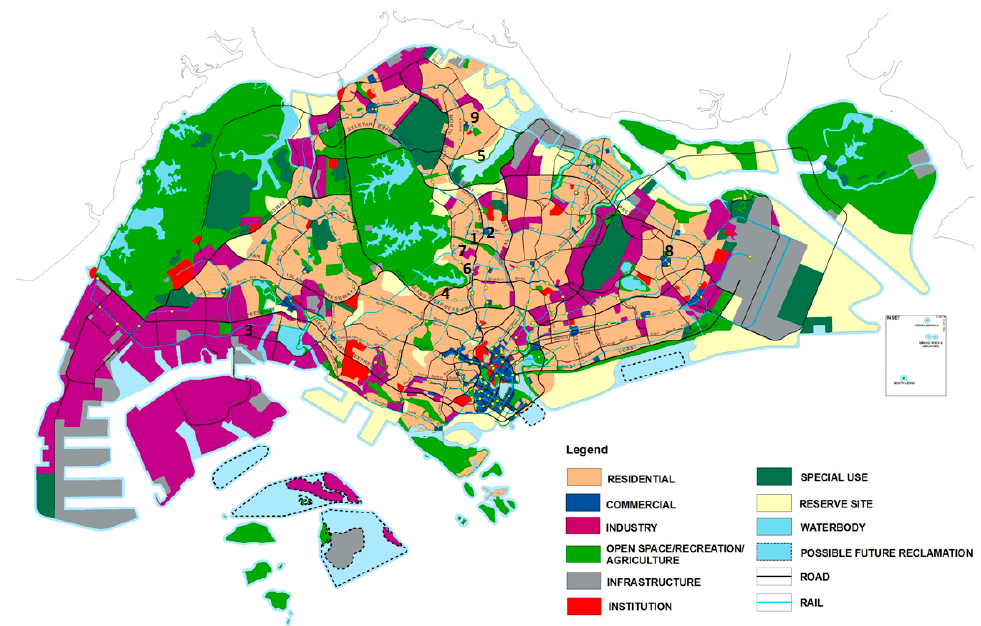
Figure 1. Sampling and monitoring sites: 1. AMK (mixed use, 4.50 ha); 2. ChengSan (commercial food